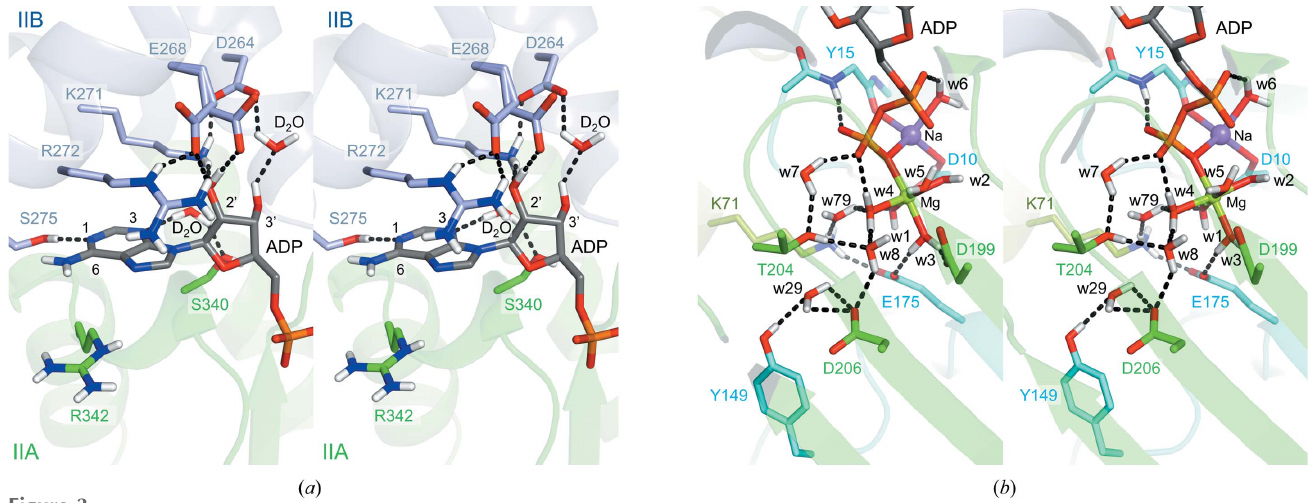
Figure 3 Atomic interactions between Hsp72 and ADP in a wall-eyed stereo representation for ( a ) the adenyl group and ribose moiety and ( b ) the phosphate moiety (PDB entry 7f4x). The C atoms of ADP and subunits IA, IIA and IIB are coloured dark grey, cyan, green and light blue, respectively. H (D), N, O, Na, Mg and P atoms are coloured while, blue, red, purple, yellow green and orange, respectively. The black dashed lines indicate hydrogen